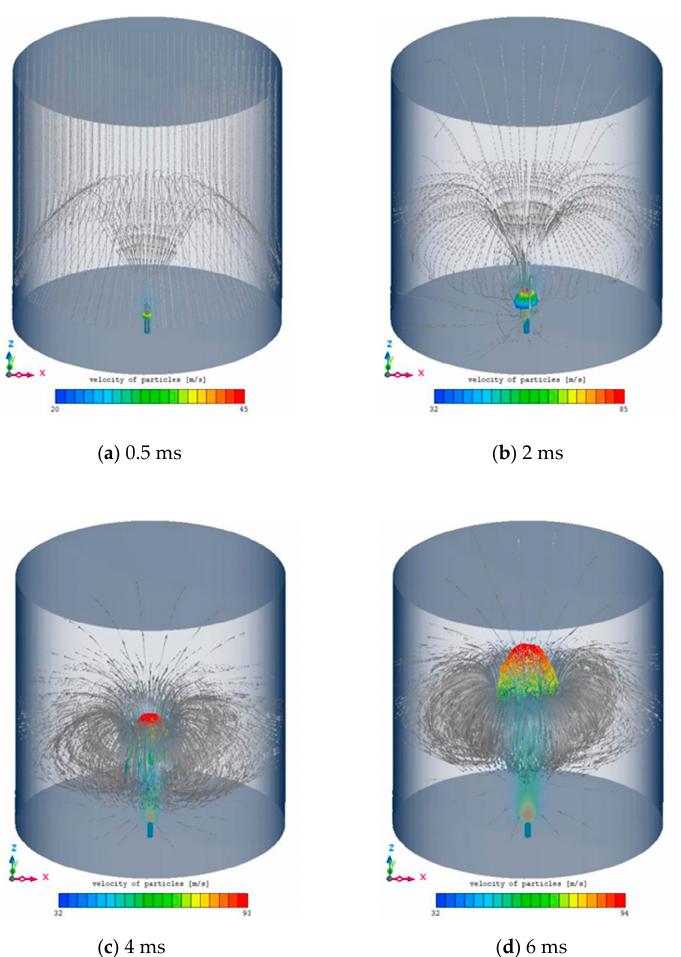
Figure 12. Evolution process of the three-dimensional annular vortex. ( a ) at 0.5 ms; ( b ) at 2 ms; ( c ) at